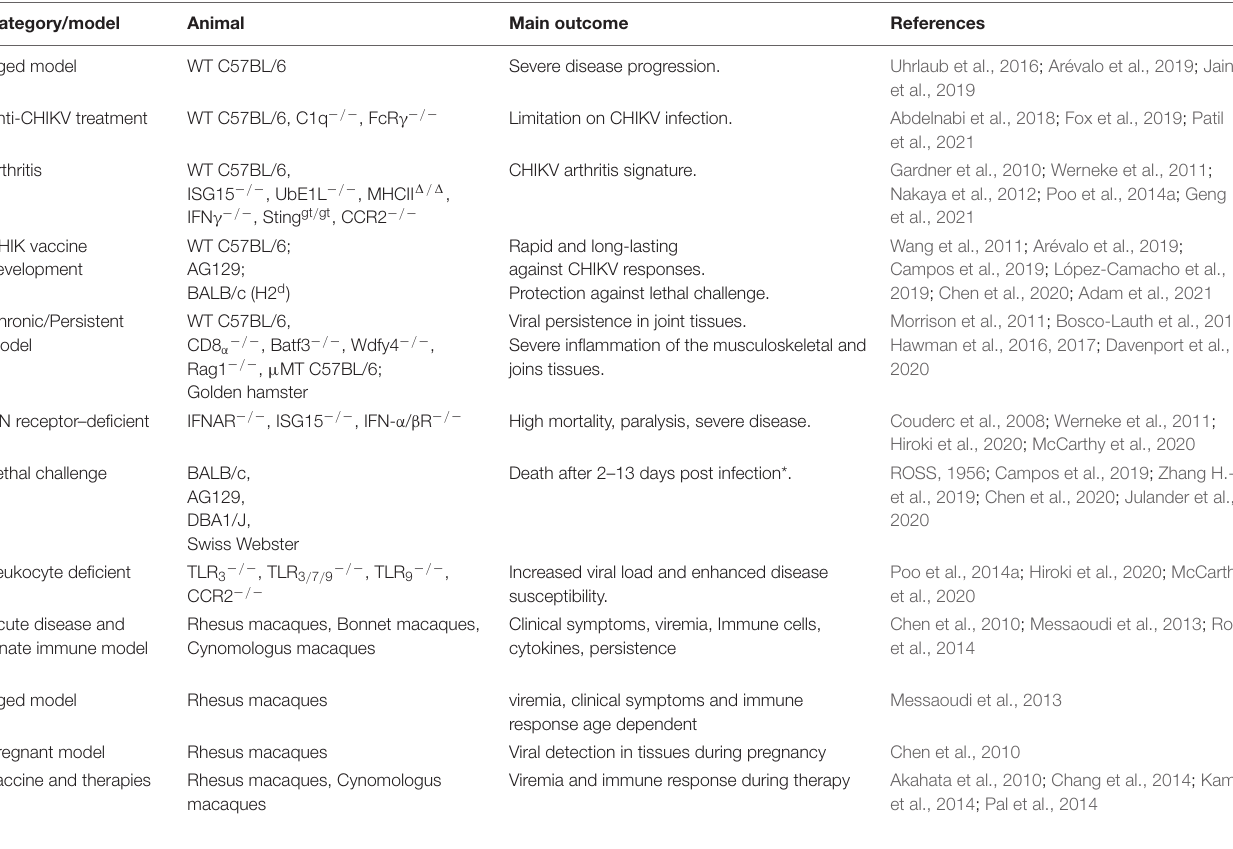
TABLE 3 | Summary of in vivo rodent and NHP models for studying CHIKV